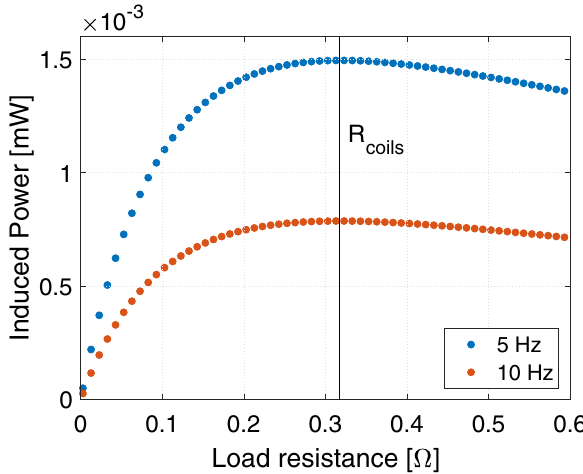
Figure 2. The induced power as function of the load resistance for the studied system starting from rest and a driving frequency of either 5 or 10 Hz for a horizontal system. The resistance of the coils have been